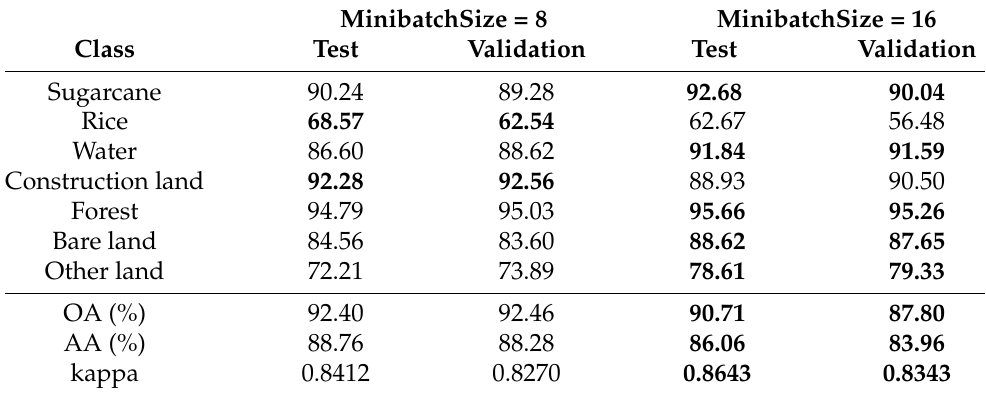
Table 3. Classification accuracy (%) for different MinibatchSize values of U-Net.